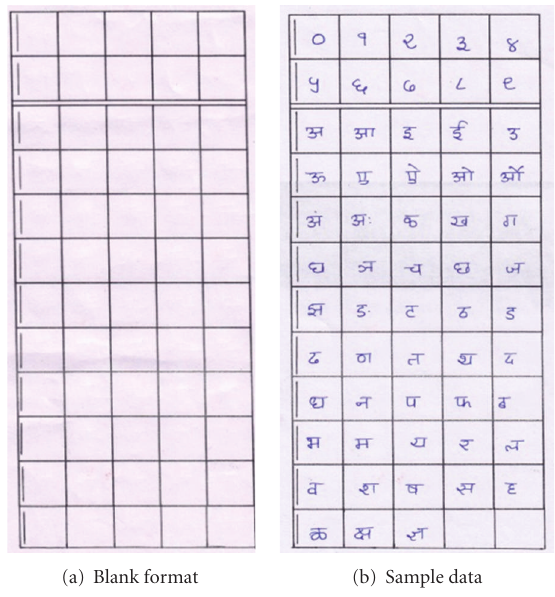
Figure 1: Handwritten data sample